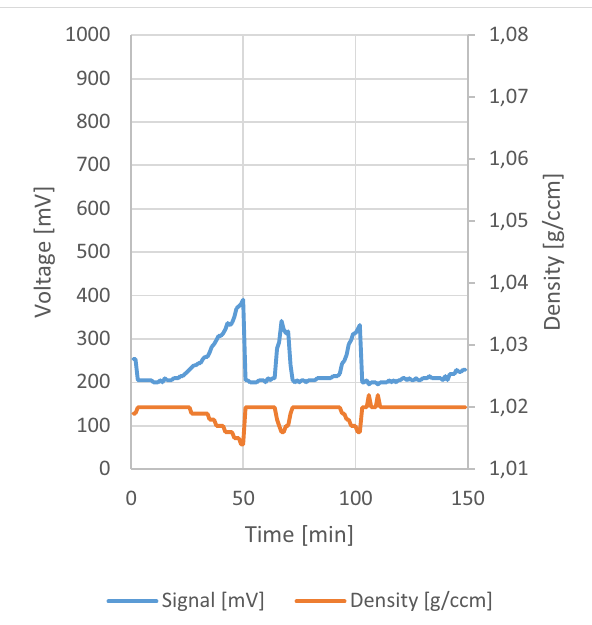
Fig. 2. Sample measurement with signal shape and density derived from